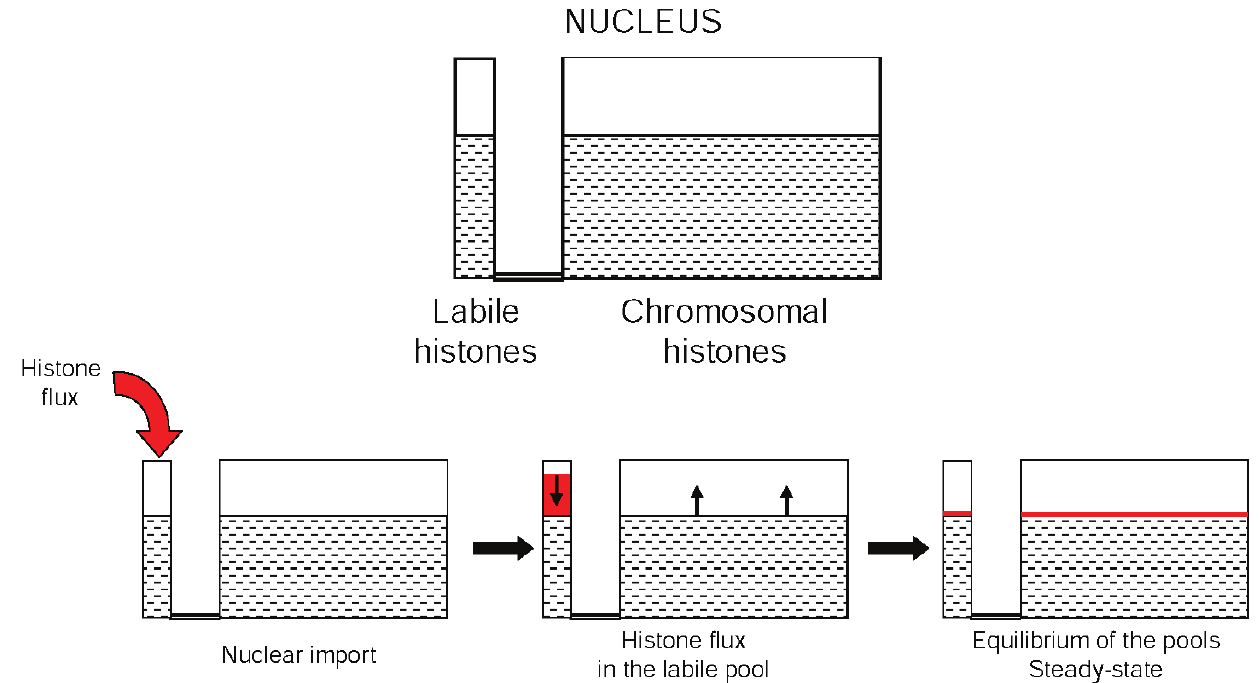
Figure 1. Schematic representation of the histone pools in the nucleus. The top scheme represents nuclear histones compartmentalized into two reservoirs, the labile histones (associated with various chaperones) and the chromosomal histones. The lower schemes illustrate the impact of the arrival of histones within the nucleus on the equilibrium of the histones ’